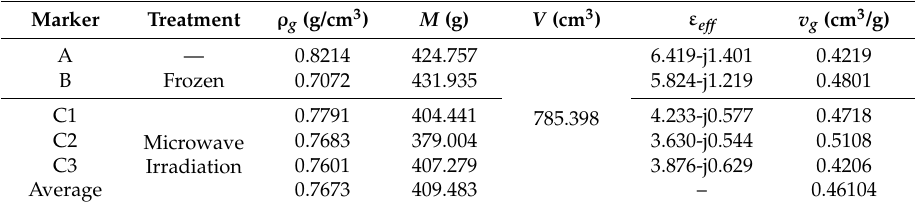
Table 1. The detailed experimental data.